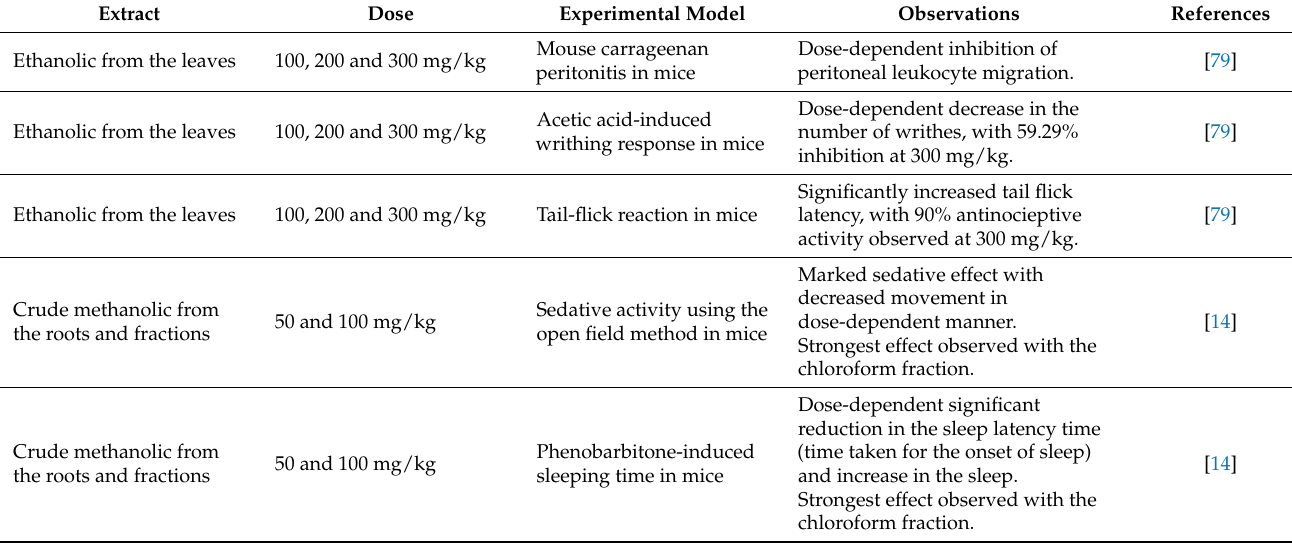
Table 10. The analgesic and sedative effects of Ziziphus nummularia